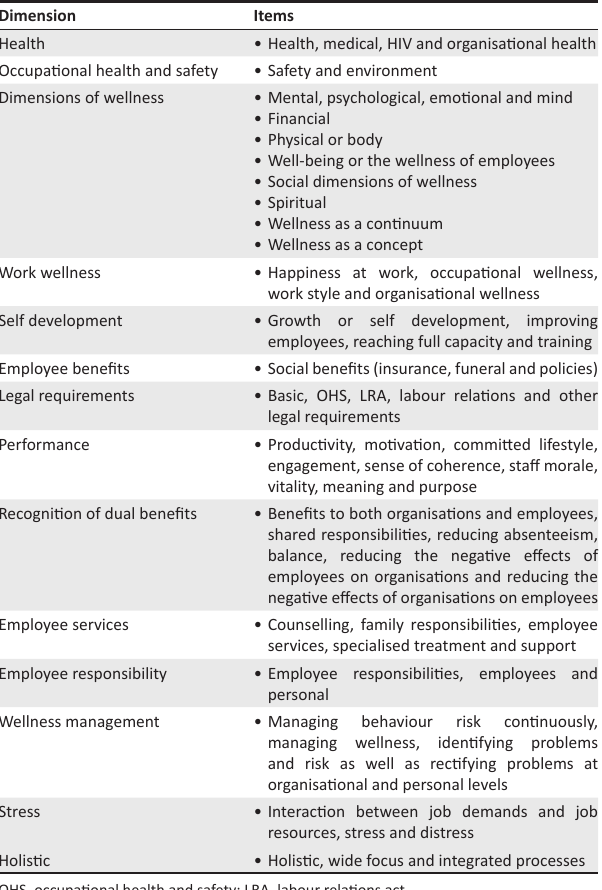
TABLE 2: Definitions of employee wellness according to participating service providers.